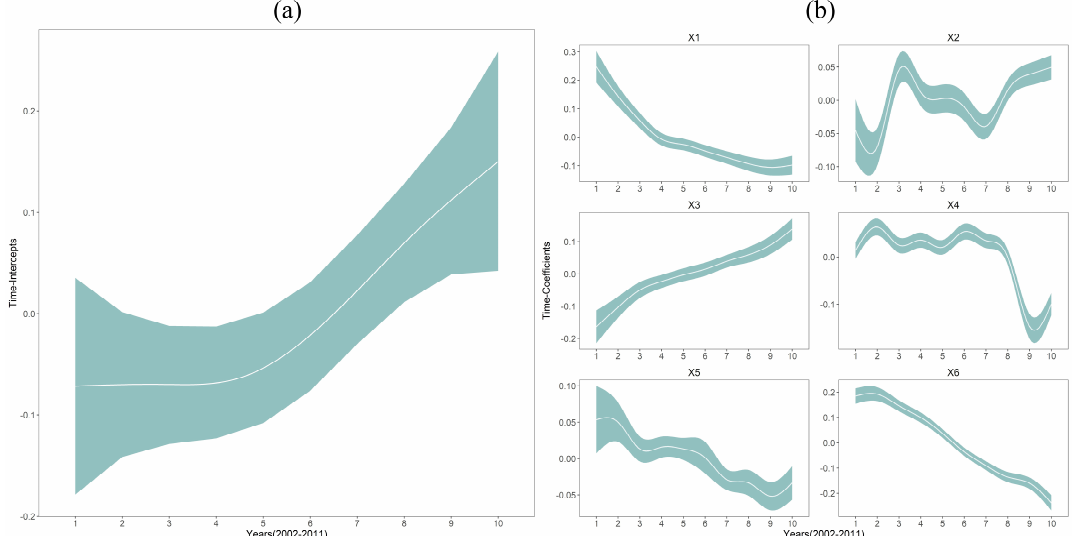
Figure 3. ( a ) Time-intercepts (TI) plot on behalf of the crude temporal variation of hospital beds in southwest China during 2002–2011, and ( b ) time-coe ffi cients (TC) plots representing the temporal heterogeneous hospital bed-covariates relationships: X1, residents’ saving deposits per capita; X2, total investment in fixed assets per capita; X3, GDP per capita; X4, urban worker population density; X5, total retail sales of consumer goods per capita; and X6, nighttime light